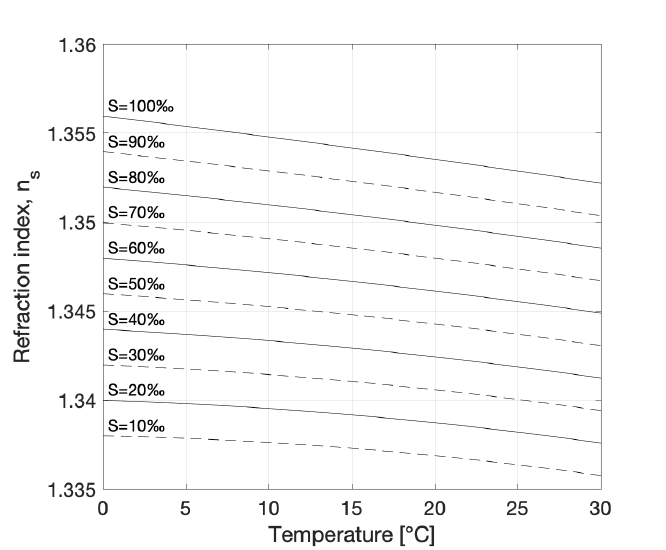
Figure 5. Refraction index for sea water at various salinities and temperatures. Only valid for the ATLAS instrument, which uses a green laser with a wavelength of 532 nm.